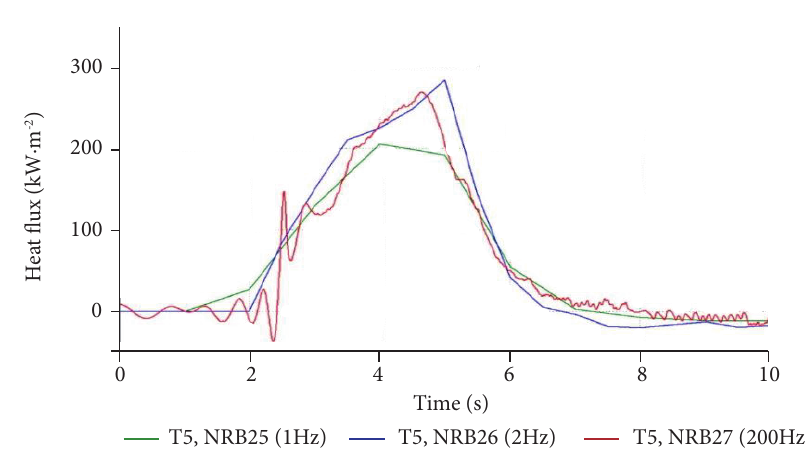
Figure 12. Heat flux from temperature history of thermocouple T5, of NBR25, 26 and 27.